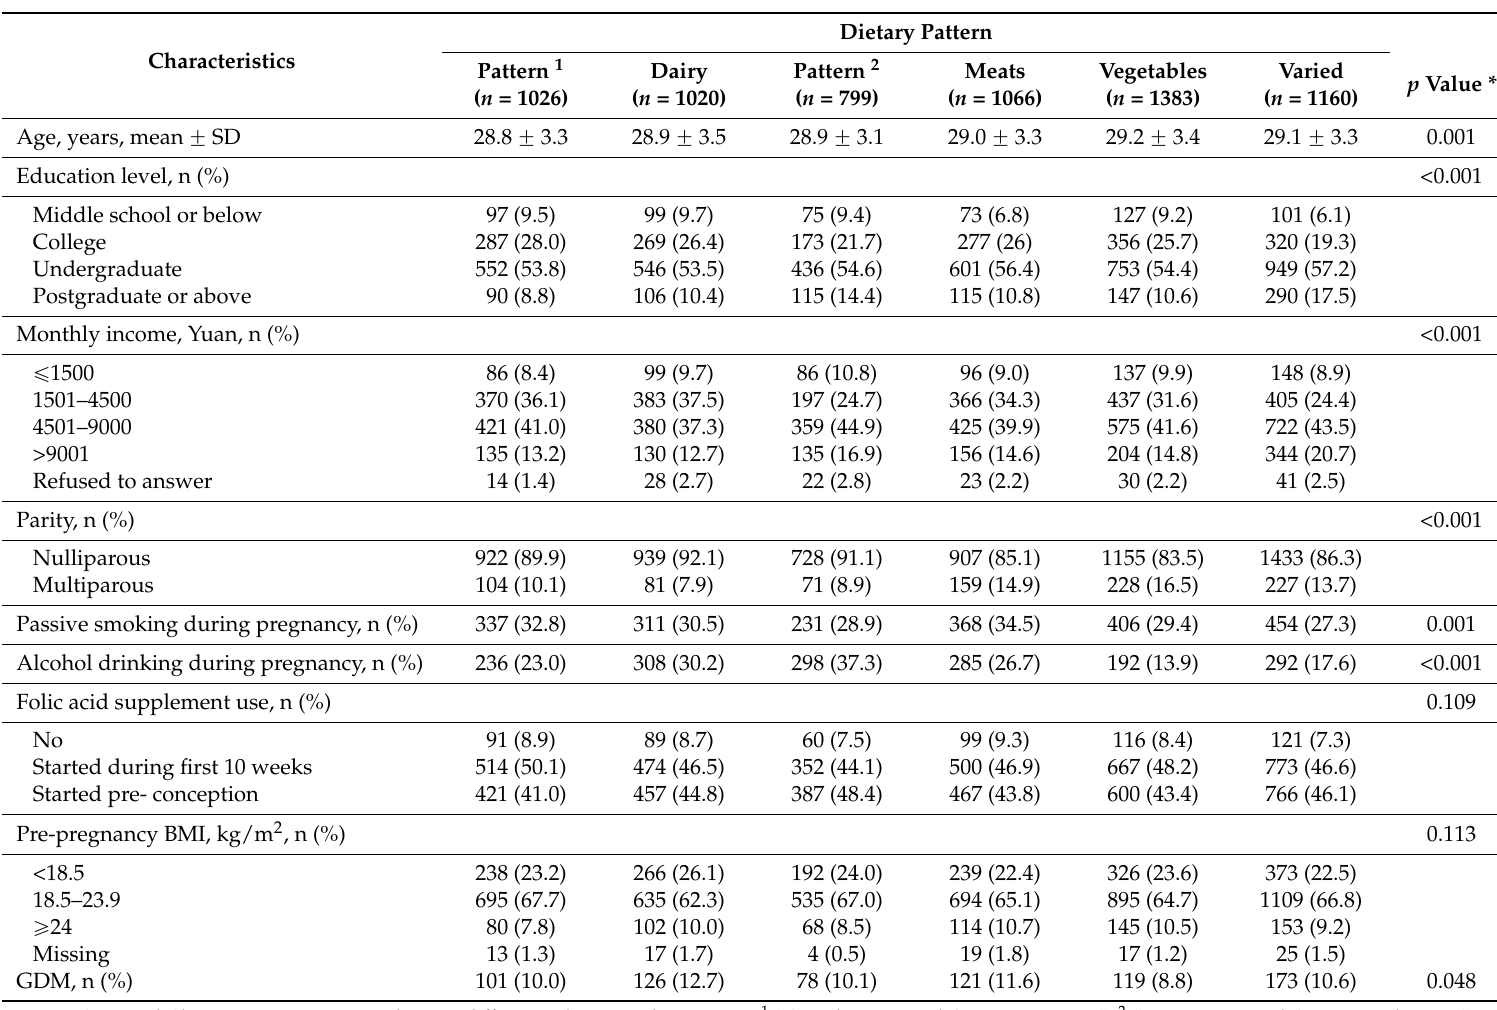
Table 2. Characteristics of the participants across the six dietary patterns identified by cluster analysis among 6954 Chinese pregnant women from the Born in Guangzhou Cohort Study. GDM refers to gestational diabetes